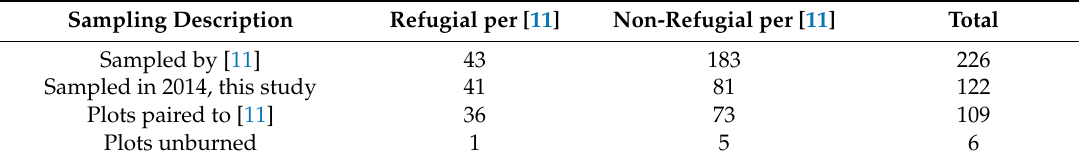
Table 5. Number of plots classified in the original Camp et al. [11] study that burned in the 2012 fires, re-surveyed in the present study, paired to the plots from [11], and found to have no fire effects (i.e., the most conservative definition of refugial) by this study.